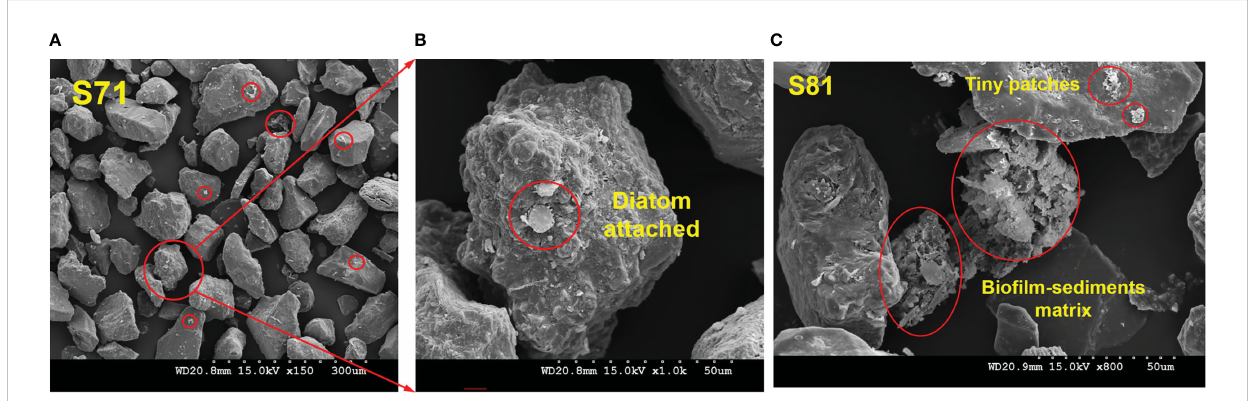
FIGURE 4 Scanning electronic images showing the micromorphology of the bio fi lm-sedimentary aggregates. Sediment samples were collected at S7 (A, B) and S8 (C) in winter,